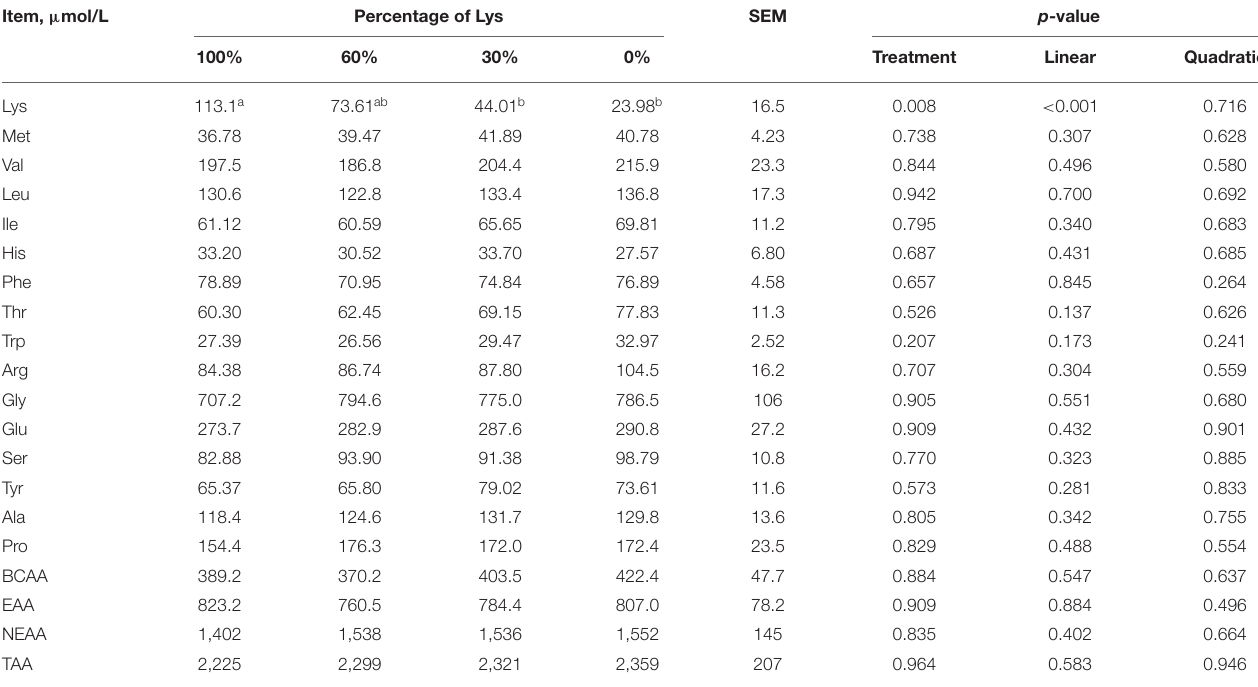
TABLE 4 | Effects of graded removal of Lys from the amino acid mixture infused into abomasum on amino acid concentrations in the plasma of carotid artery in lactating goats. Item, µ mol/L